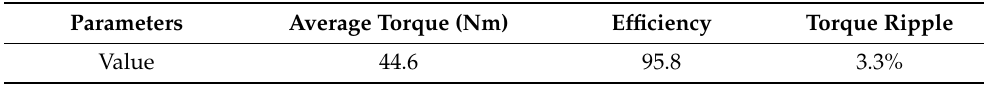
Table 6. Performance indicator.